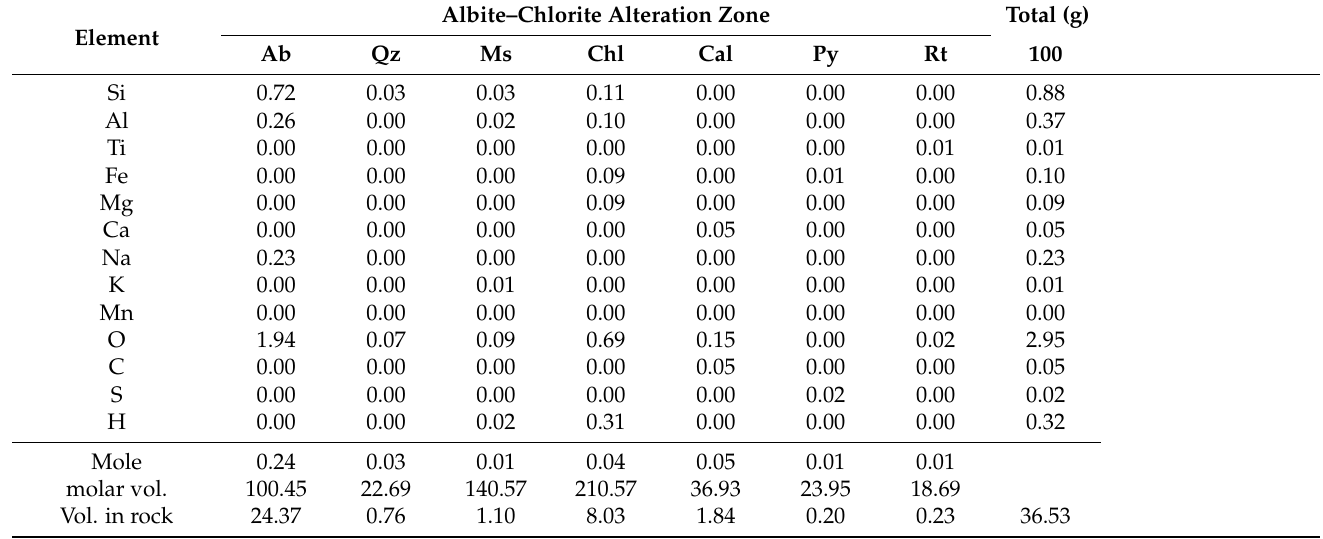
Figure 6. Gains and losses of elements during alteration of phyllites: ( a ) least altered phyllite to the albite–chlorite alteration zone, ( b ) albite–chlorite alteration zone to the albite–ankerite–pyrite alteration zone and ( c ) least altered phyllite to the albite–ankerite–pyrite alteration zone. Alteration in the albite–ankerite–pyrite zone involved a mass increase of 22.7% and volume decrease of − 0.1% compared to the albite–chlorite alteration zone. The reaction is represented by the significant addition of Si, Ca and Na, with the concomitant removal of Mg and K (Table 7 and Figure 6b). The balanced reaction indicates that 100 g precursor sample from the albite–chlorite alteration zone reacted with 0.12 mole (1.45 g) CO 2 and Table 7. Quantified compositional data for the albite–chlorite alteration zone and the albite–ankerite–pyrite alteration zone. The calculation was based on modal and mineral compositions balanced for immobile Al and a 22.7% mass increase. The difference indicates gain or loss/100 g for components and in % for volume changes in rock.